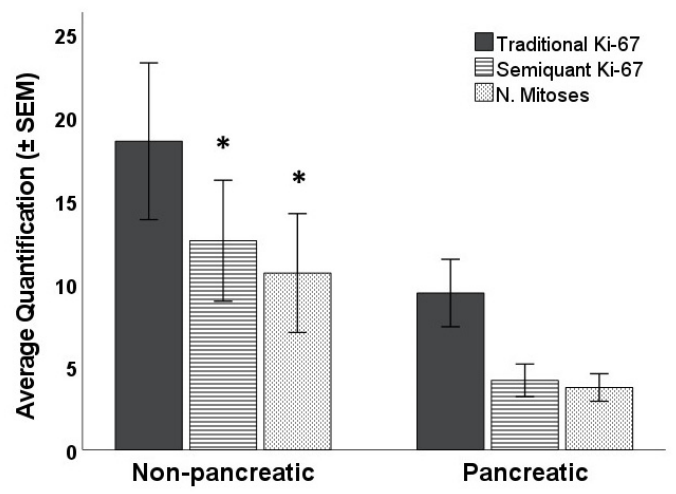
Figure 4. Number of mitoses, traditional Ki-67, and semiquantal Ki-67 difference by NETs location (pancreatic vs. non-pancreatic). (* = p < 0.05). Table 3. Correlation between clinical data and measures of cellular proliferation.